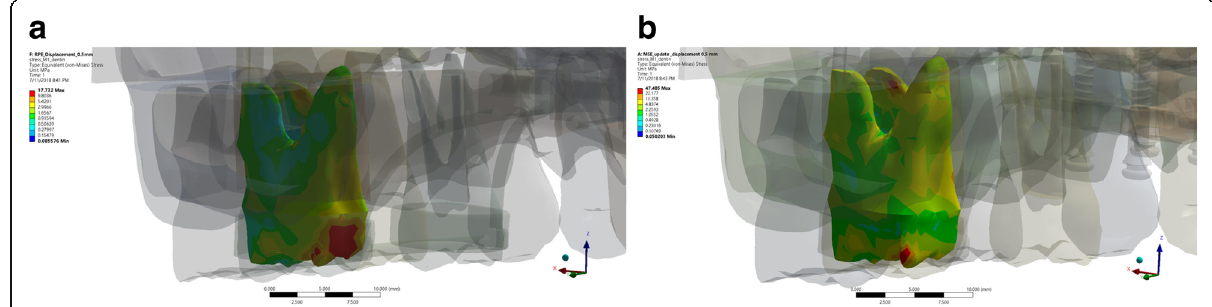
Fig. 1 The von Mises stress distribution on the maxillary first molar in the expansion simulation using ( a ) RME, and ( b ) MSE